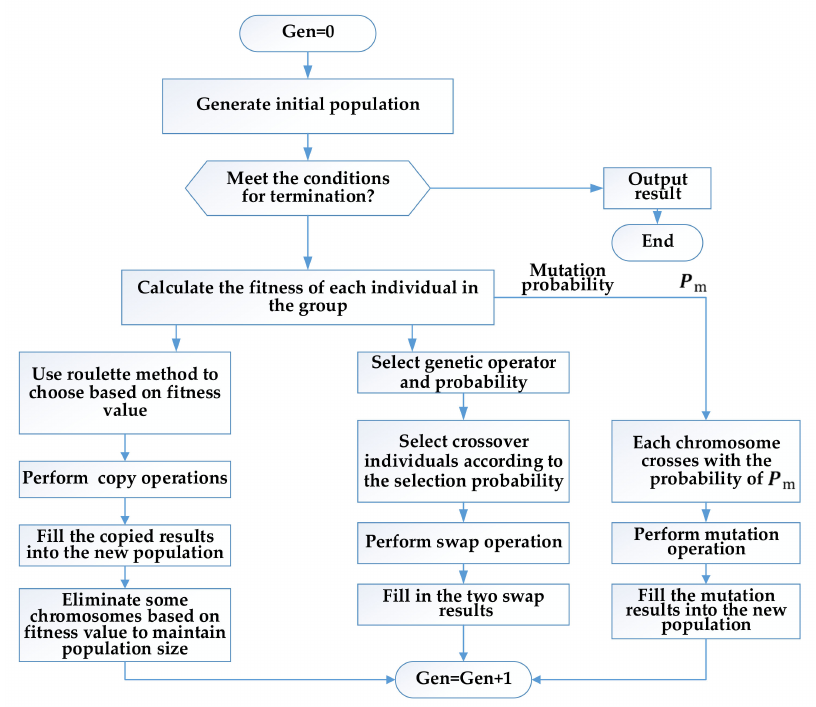
Figure 7. Algorithm flow of genetic